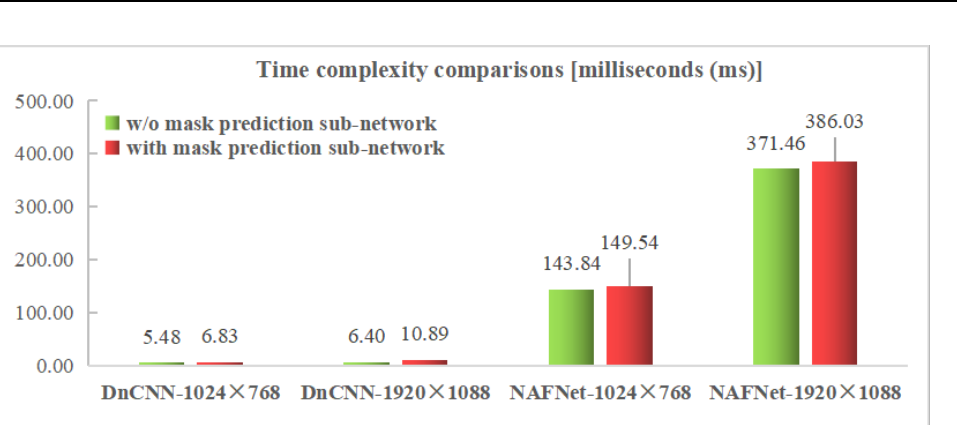
Figure 9. Time complexity comparisons between SVQE models with and without DIBR distortion mask prediction